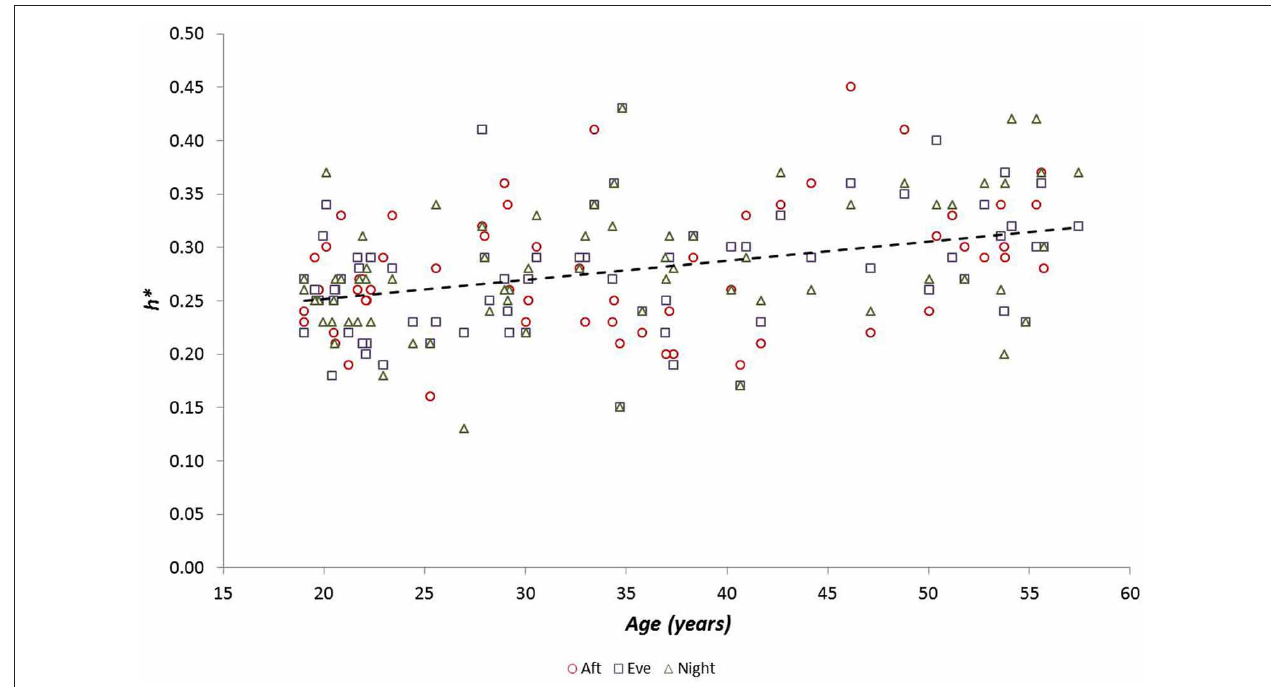
FIGURE 4 | Modal h ( h ∗ ) as a function of participant age during Afternoon, Evening and Night periods (there was no relationship between h ∗ and age during the Morning period).